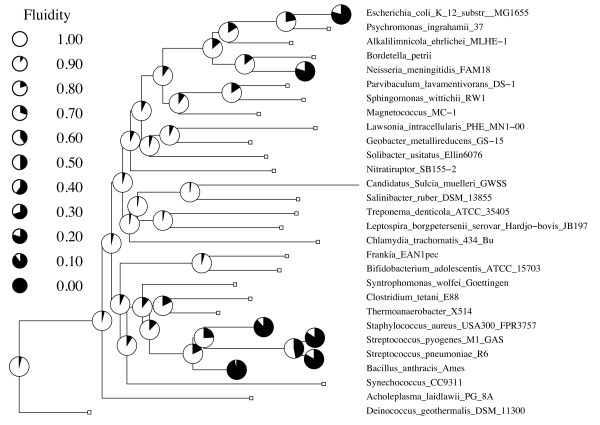
Fluidity increases with phylogenetic scale. Fluidity of multiply-resequenced species is in the range of 0.1 - 0.3 and the fluidity of all genomes included in the analysis approaches 1. Each circle represents the relative fluidity at a species (with multiple sequenced genomes) or internal node (the fluidity of all the genomes in the tree below it). Open circles are φ = 1 and black circles are φ = 0. The phylogenetic tree of 29 bacterial species was assembled using AMPHORA [2]. Branch lengths correspond to the average number of amino acid substitutions per position in well-conserved marker genes.